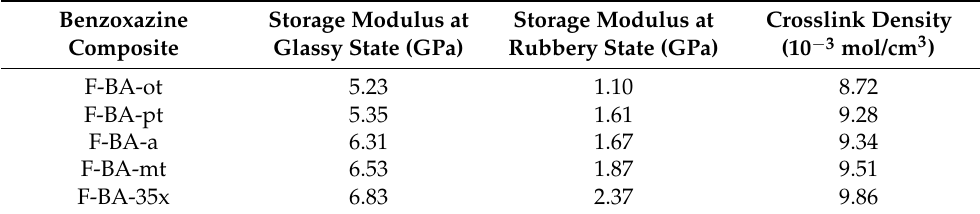
Table 2. Storage modulus and crosslink densities obtained from the dynamic mechanical analysis (DMA) of polybenzoxazine composites.